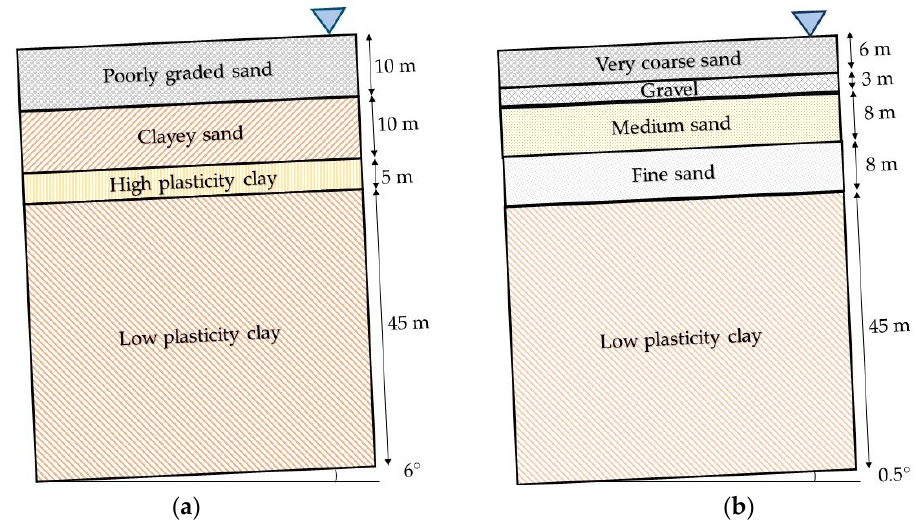
Figure 15. Soil layout at ( a ) the Lo Rojas site, and ( b ) the Matanuska site